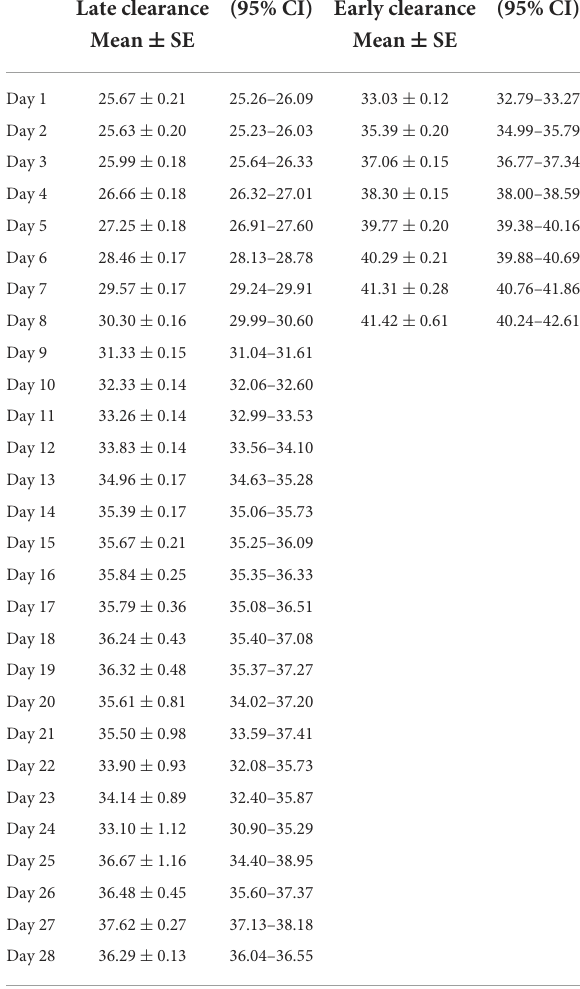
TABLE 5 Ct values of N gene over time after admission (Mean ± SE, 95% CI).